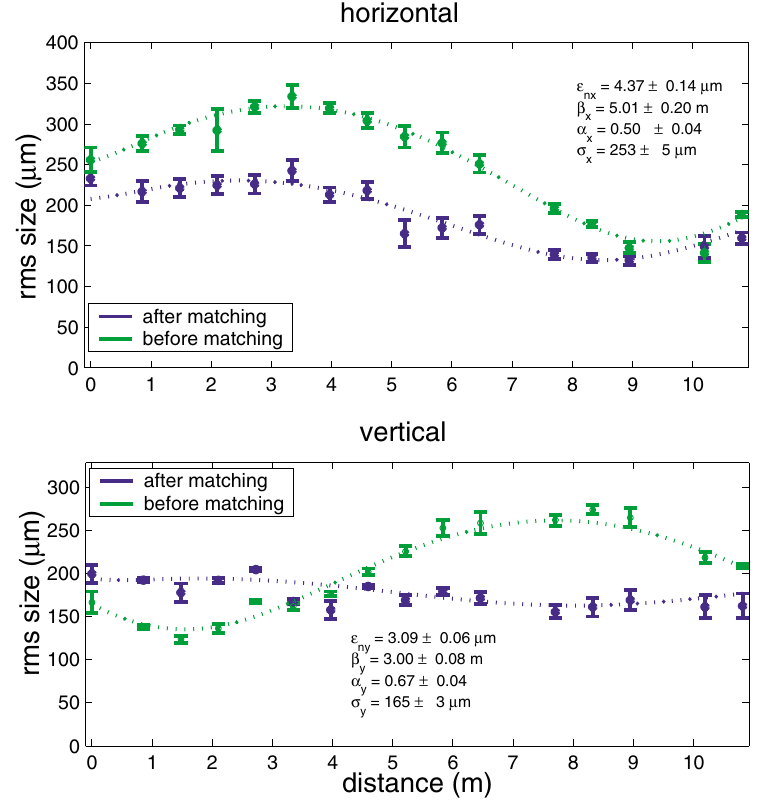
FIG. 3. (Color) Beam matching into the Nisus wiggler using automated MATLAB routines. In figure " emittance, (cid:8) and (cid:9) are Twiss parameters, and (cid:10) is the beam